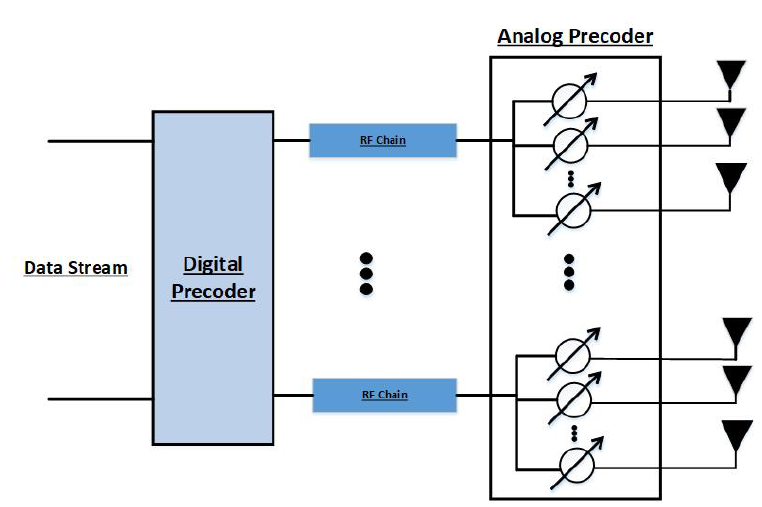
Figure 1. HAP massive MIMO system with user K.